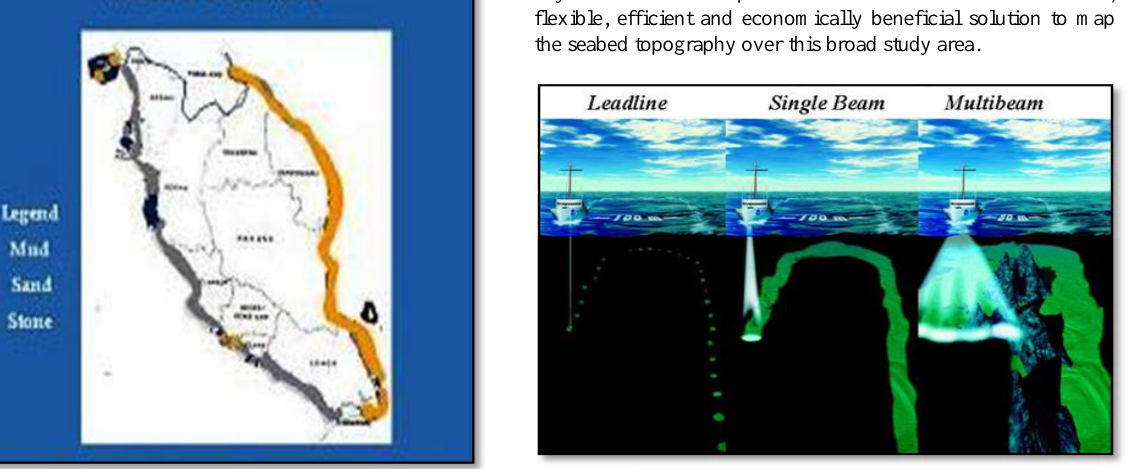
Figure 2. Coastal sediments along the coastline of Peninsular Malaysia (DID, 2017).